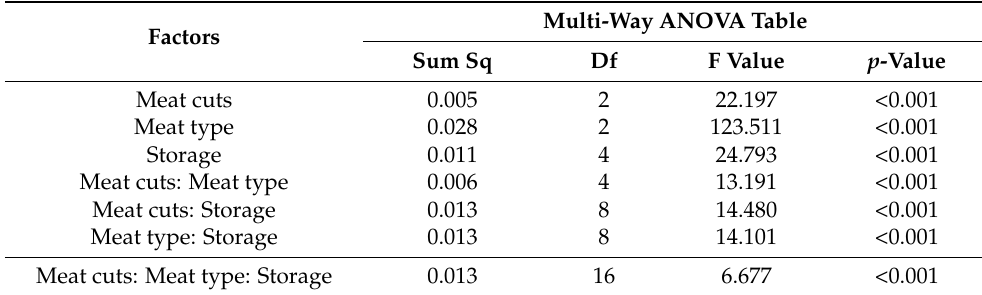
Table 7. The results of multiway ANOVA